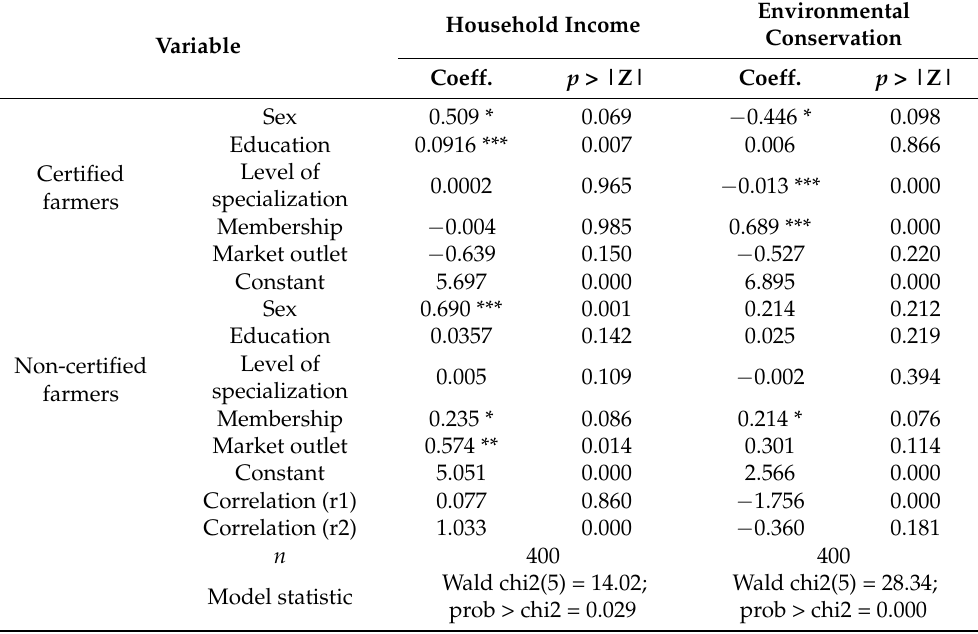
Household Income